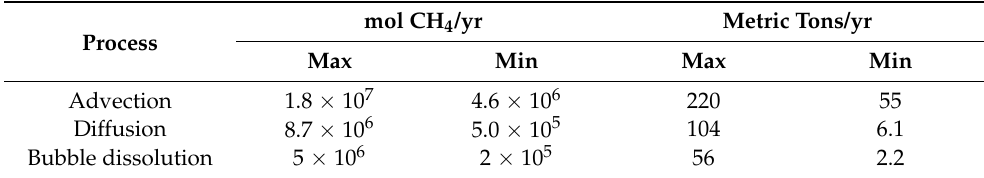
Table 2. Methane source mass loading estimates. Calculated inputs of methane for advection, molecular diffusion, and dissolution from